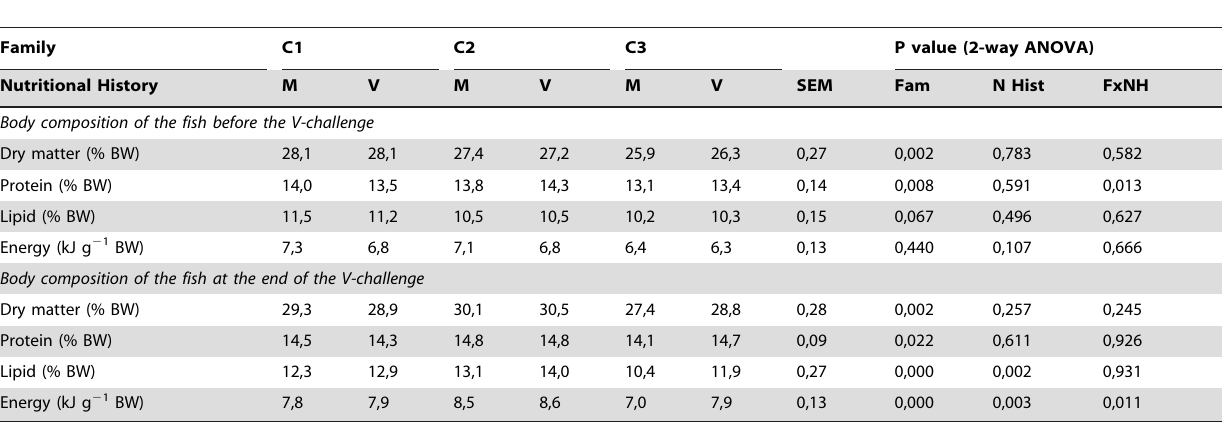
Figure 1. Voluntary feed intake (FI) of the trout during the last week of acclimation when feeding diet M and over three consecutive periods of the 25-day V-challenge with diet V. FI data represent means 6 SEM (n=4, except for C3M and C1V with n=3) according nutritional history (M or V) and family (C1, C2, C3). For each period, the significance of the effects of nutritional history, family and their interaction (2-way ANOVA) is provided in the figure, * indicates a significant effect of nutritional history (V . M, p , 0.05).